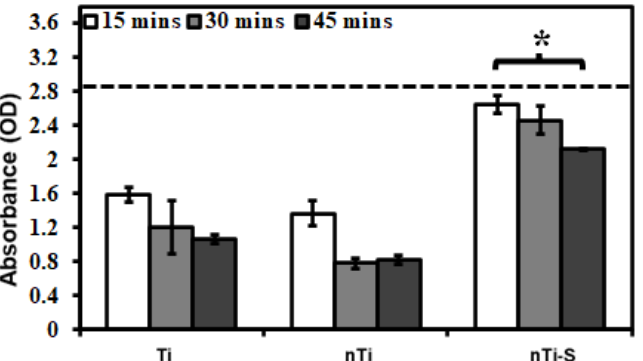
Figure 7. Complement activation of plasma incubated with different surfaces was measured as activation of complement convertase C5a. The lines indicate the regions of inactive/low ( ≤ 0.2), medium (>0.2 and ≤ 0.6), and high (>0.6) reactivity. (n min = 9.)